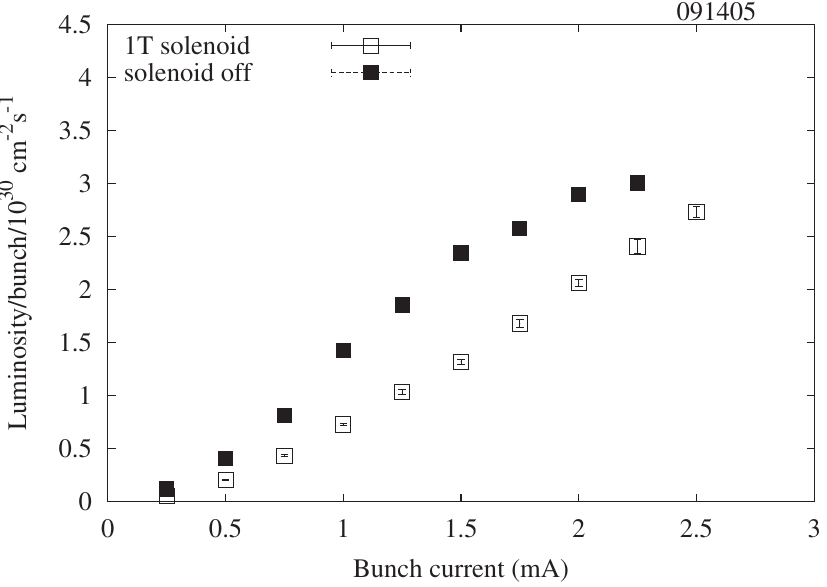
FIG. 14. Simulated luminosity for the solenoid off optics and standard cesr-c optics with 1 T